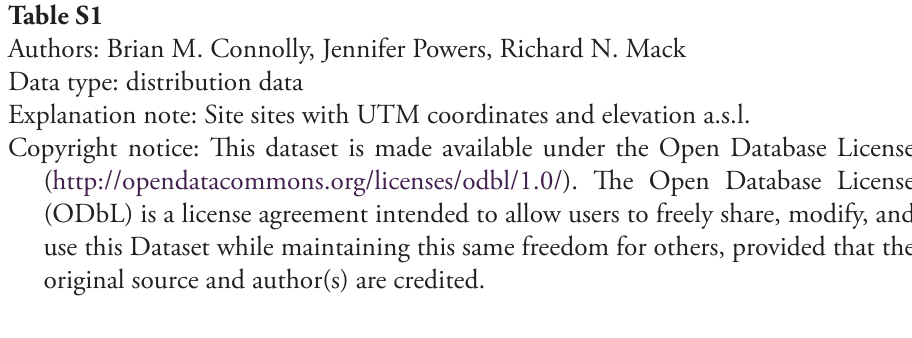
Data type: distribution data